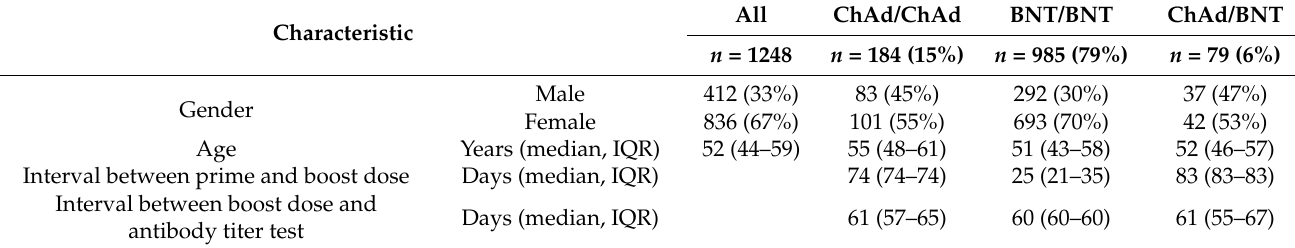
Table 1. Characteristics of the three groups of vaccinated